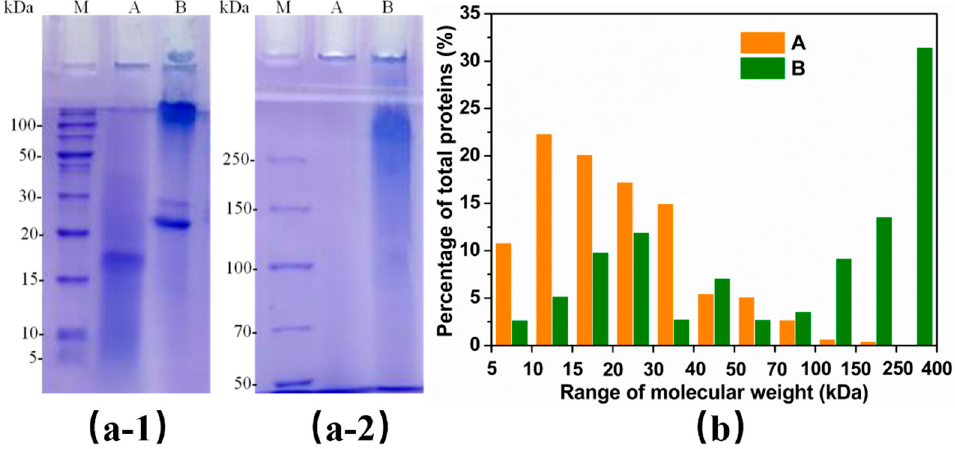
Figure 6. ( a-1 ) and ( a-2 ) SDS-PAGE patterns of regenerated SF derived from different degumming methods. ( M ) Molecular weight marker, ( A ) Na 2 CO 3 -SF, ( B ) 3.0 g/L papain-SF. Separating gel concentration: ( a-1 ) 15%, ( a-2 ) 6%. ( b ) Semi-quantitative statistics of molecular weight distributions (MWDs) based on SDS-PAGE patterns.